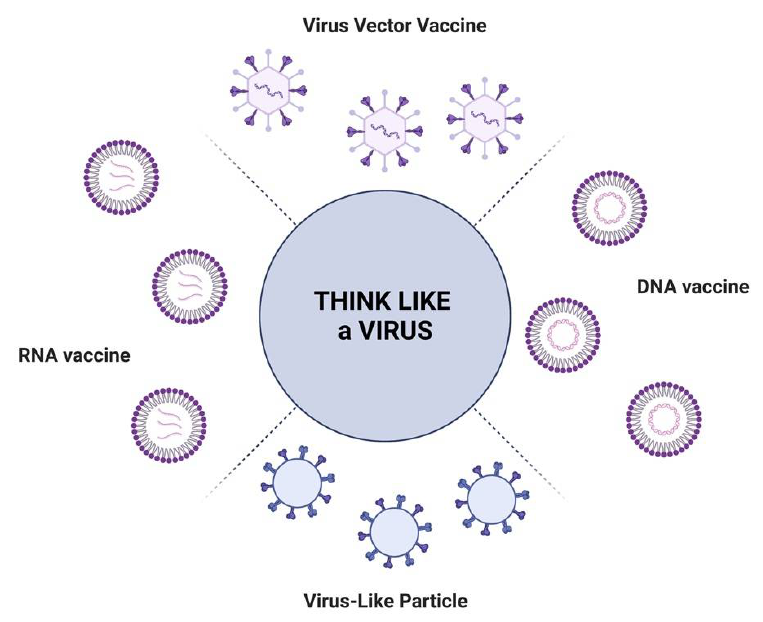
Figure 2. Illustration of the different vaccine strategies exploiting nanoformulations.